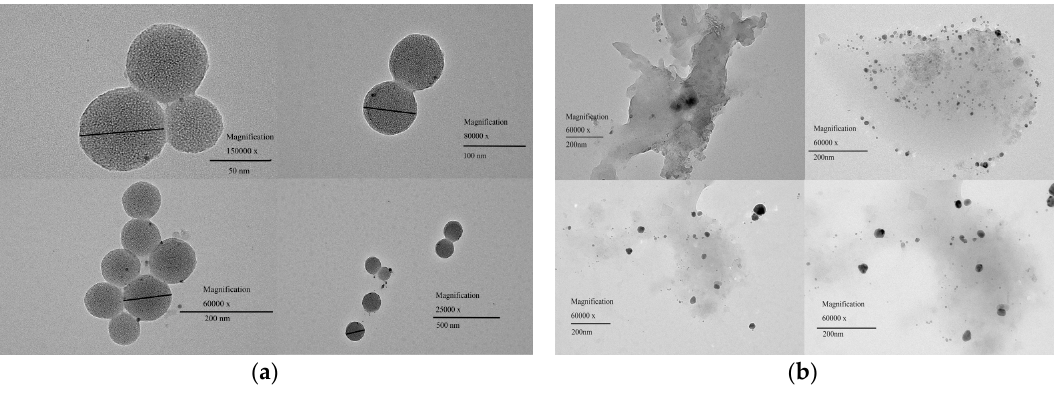
Figure 5. TEM of AgNPs and m ss = 0.5 g hydrogel.